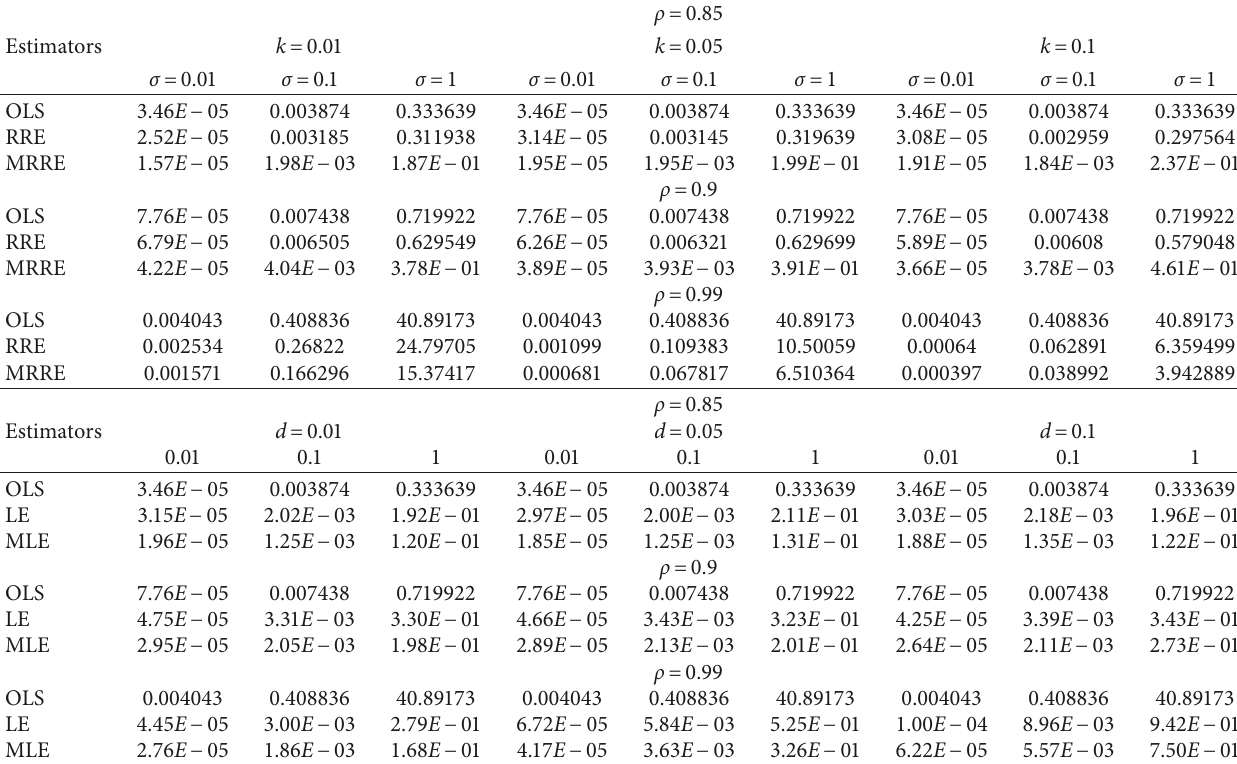
Table 3: Estimated MSE values of the OLSE, RRE, MRRE, LE, and MLE when n � 50.